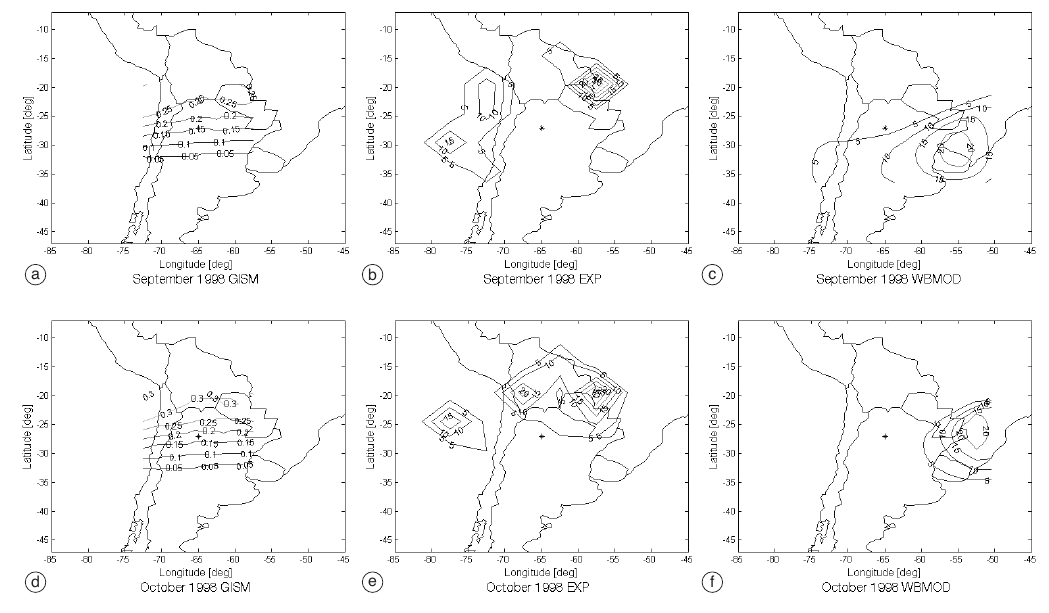
Fig. 1a-f. Percentages of occurrence of S 4 > 0.5 for experimental data and WBMOD and predicted S 4 values by GISM are shown at 20 LT (September and October